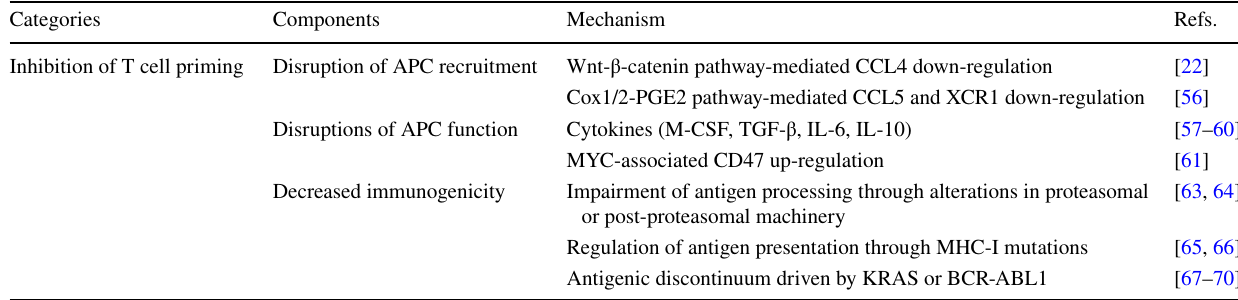
Table 1 Characteristics of T cell priming inhibition in cold tumors